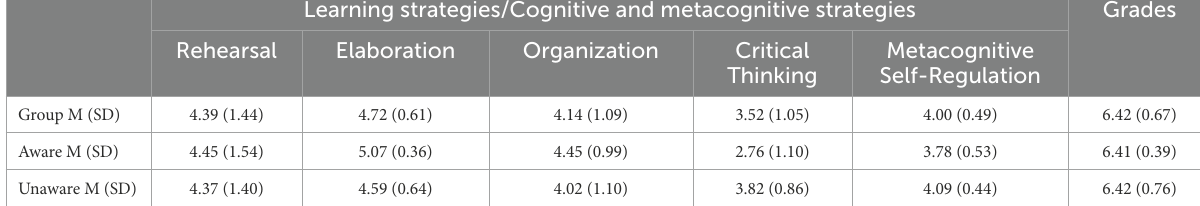
TABLE 2 Group mean and SD for MSLQ and